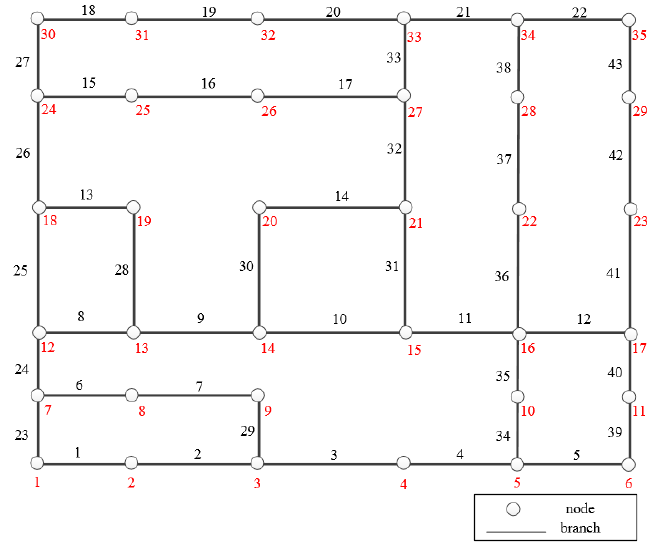
Figure 15. The model of the substation grounding grid.